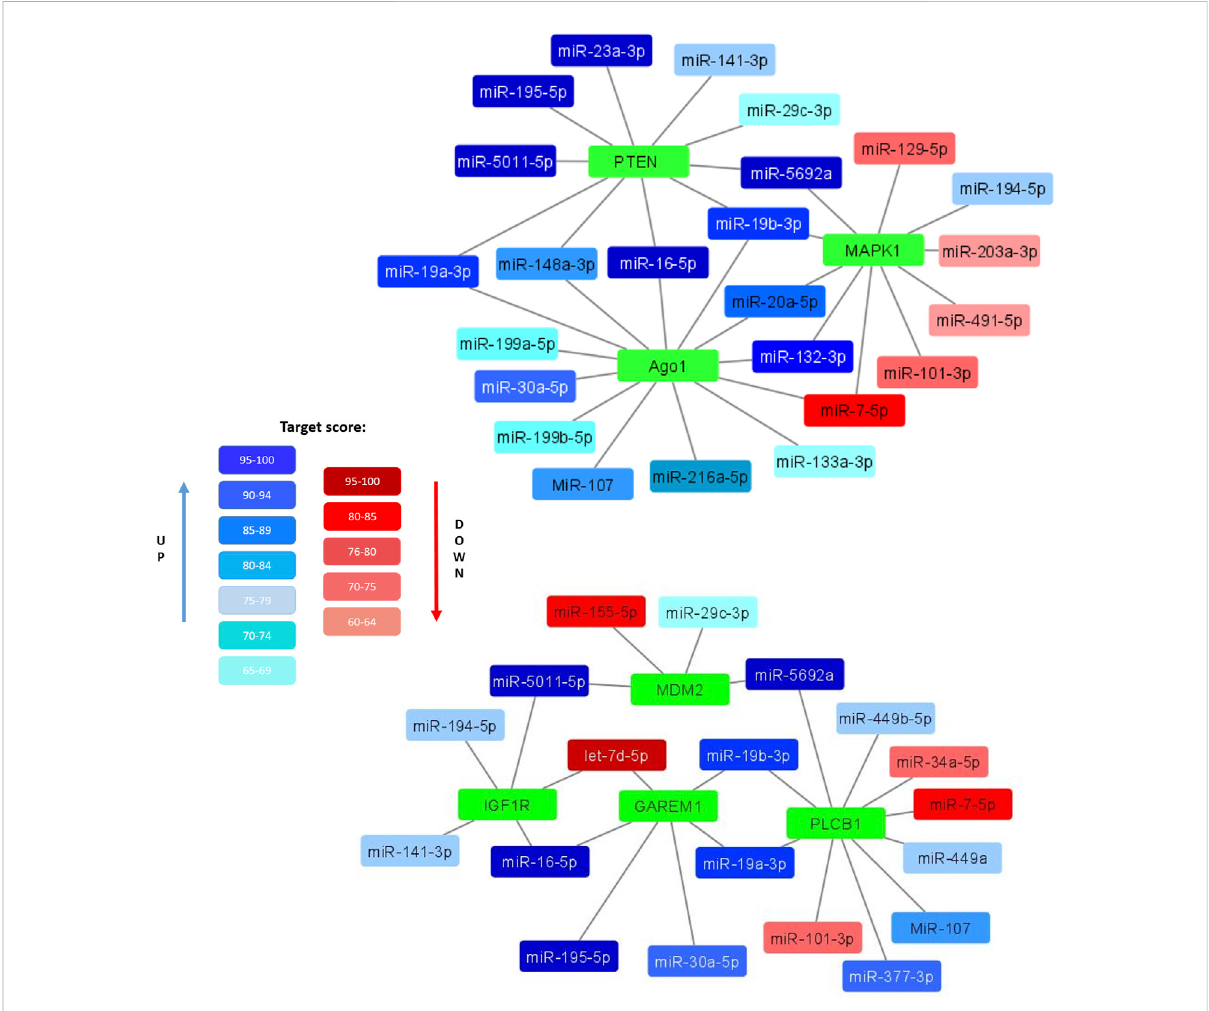
FIGURE 4 Selected miRNAs differentially expressed in EVs secreted by control and senescent MSCs along with their targets. Interaction maps illustrated differently expressed miRNAs as edges and their potential target mRNA as nodes. Coloured miRNAs are shown if signi fi cantly reduced (red) or enhanced (blue) in MSC-EVs from aged donors compared to young ones. The degree of color saturation shows the value of the target score level (relative units). A more saturated color indicates a higher value, and therefore a high reliability of the relationship between the miRNA and its